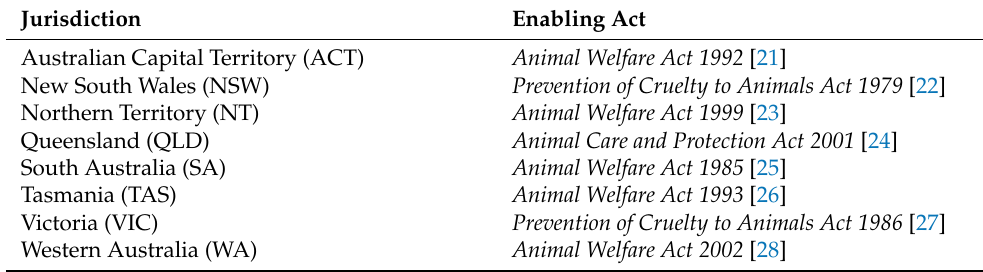
Table 1. Enabling acts for each animal welfare subordinate legislation included for